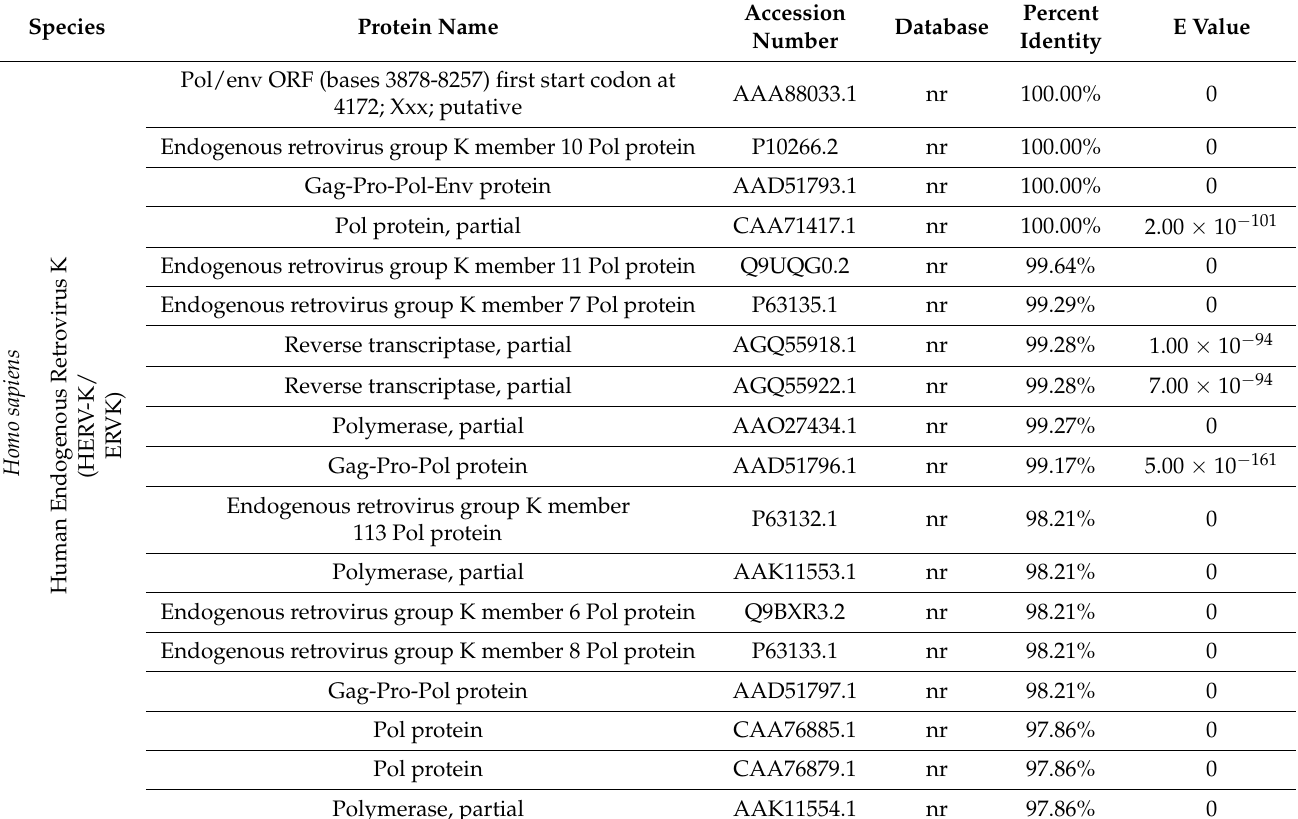
Table A2. Boreoeutherian genomes with similarity to ERVK integrase based on BLASTp searches.